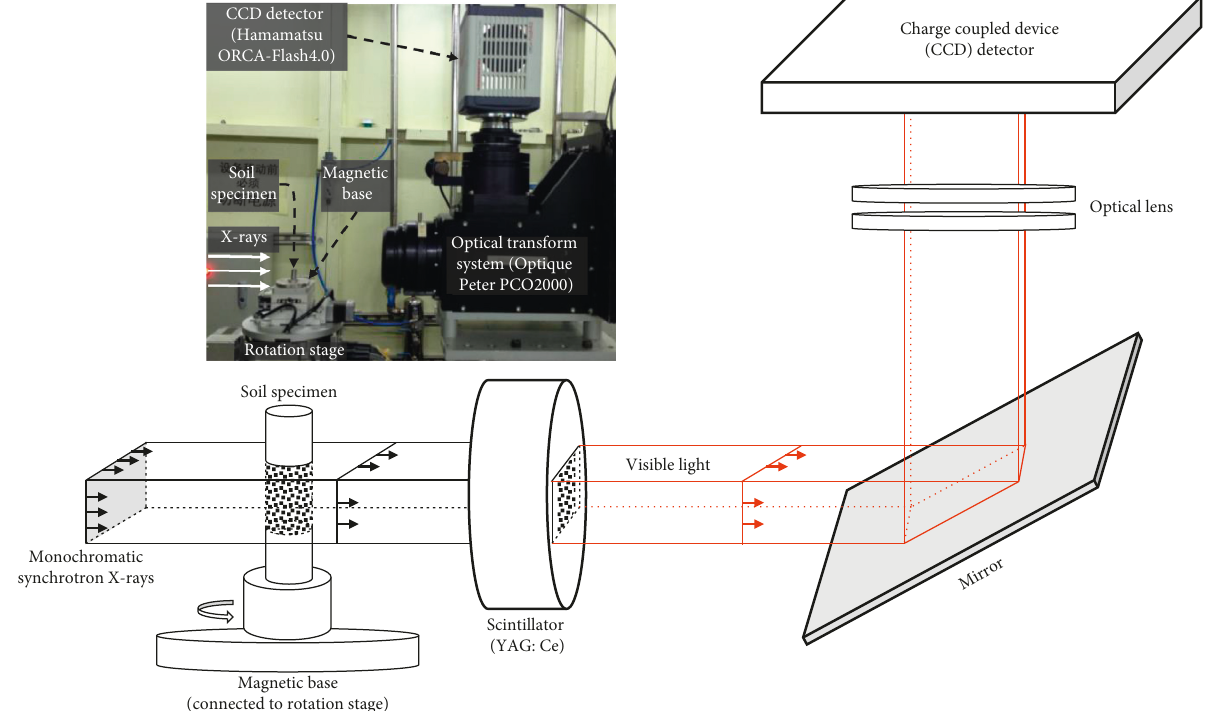
Figure 3: Experimental setup of the μ -CT at the BL13W1 SSRF. Table 2: Tests performed in this study.